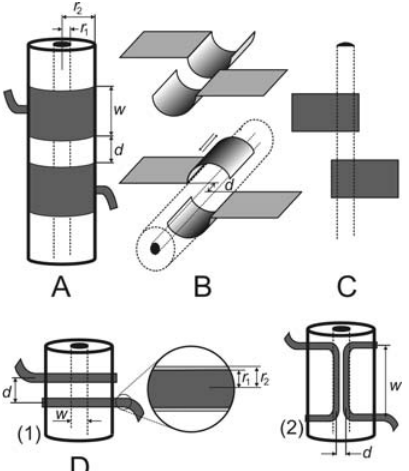
Figure 2. Examples of contactless impedance cell designs used mostly for conductometric detection. ( A ) tubular electrodes; ( B ) semitubular electrodes placed either in series or